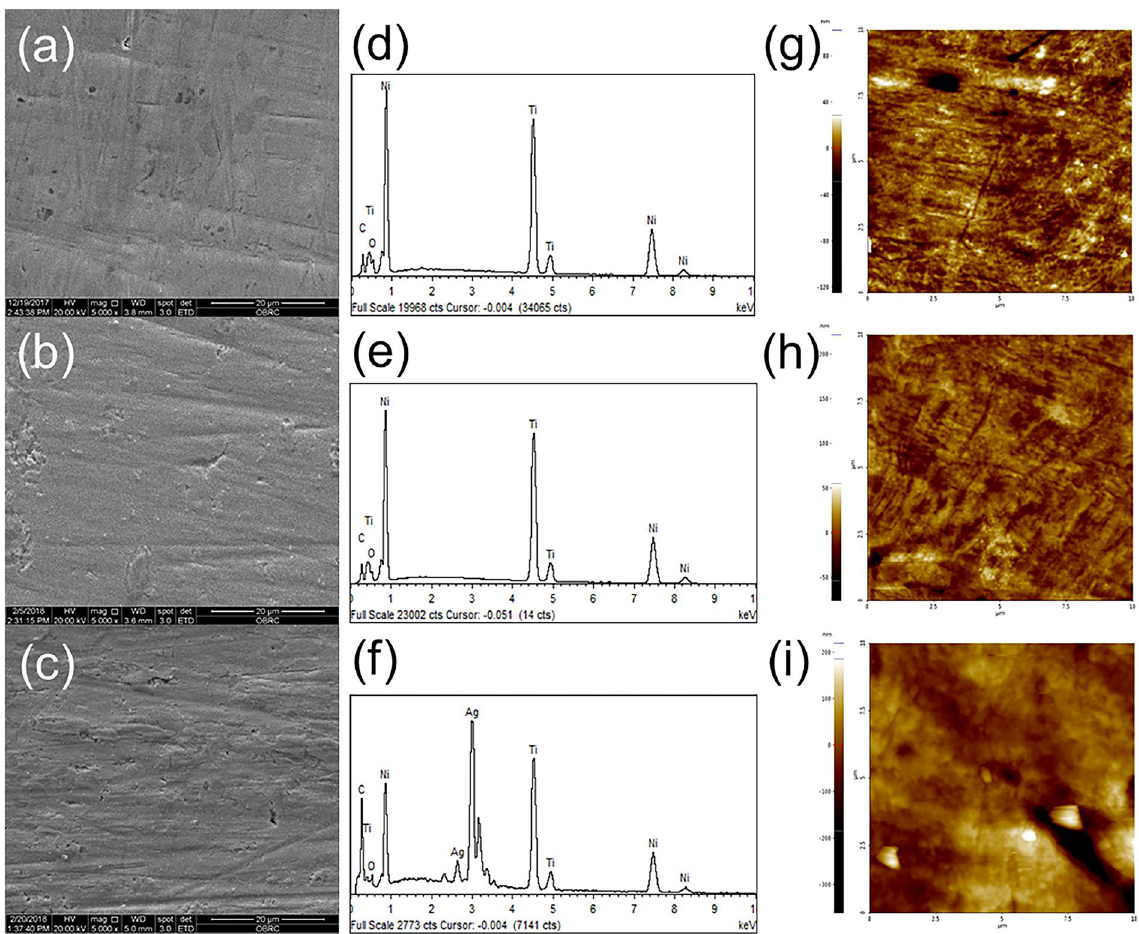
Figure 2. ( a – c ) SEM images, ( d – f ) EDS analysis, and ( g – i ) AFM images of the bare NiTi, GO-coated NiTi, and GO/Ag-coated NiTi alloy, respectively.